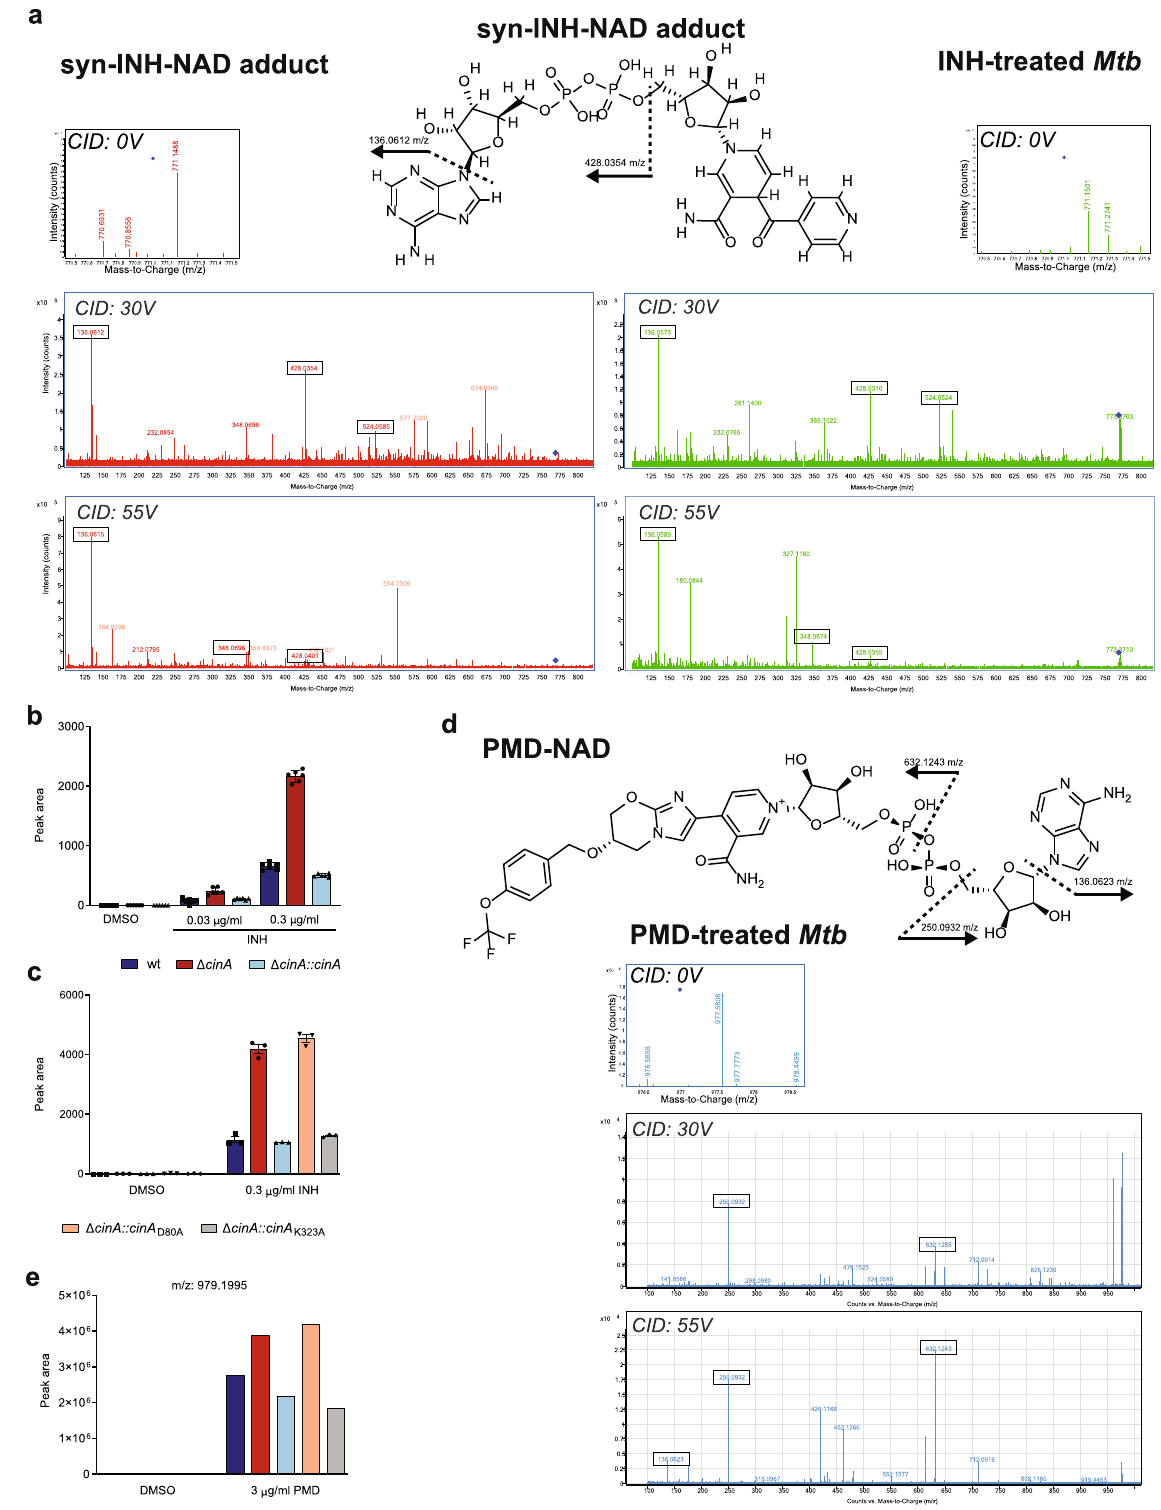
emergence of drug-resistant bacteria, but the drug-resistant population of Δ cinA was smaller than the one that emerged in drug-treated wild-type Mtb . This suggests that CinA inactivation could delay the appearance of drug-resistant Mtb . This work also underscores that drug tolerance does not always rely on slowly or non-growing cells, because the pyrophosphatase activity of CinA impaired drug mediated killing of actively replicating Mtb .